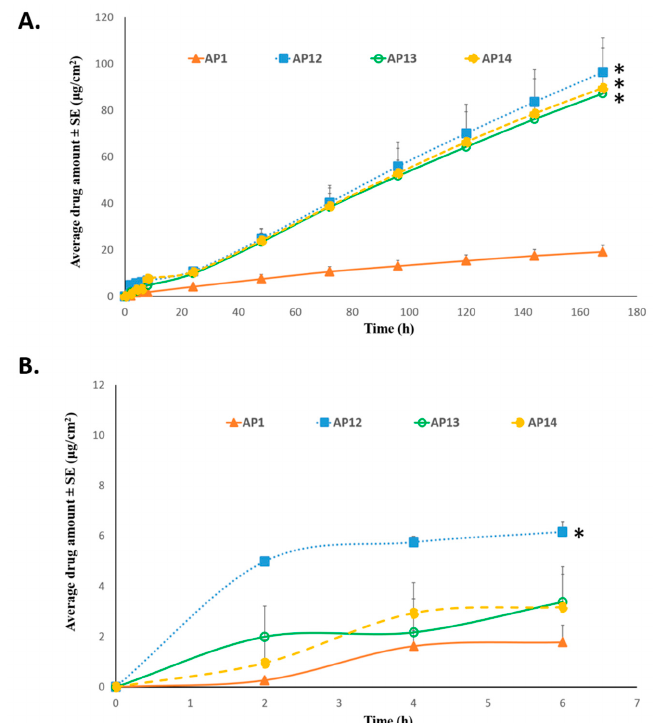
Figure 5. Effect of combination of enhancers and higher patch coat weight on permeation of TAF across human epidermis from acrylate patches: ( A ) Seven day permeation profile ( B ) Six hours permeation profile. * Represents statistically significant difference, ANOVA one way test ( p < 0.05). AP1: Acrylate based patch containing 2% TAF and 5% oleic acid. AP12: Acrylate based patch containing 2% TAF, 5% oleic acid, 5% PG, and 5% oleyl alcohol. AP13: Acrylate based patch containing 2% TAF, 5% oleic acid, 5% PG, and 5% triacetin. AP14: Acrylate based patch containing 2% TAF, 5% oleic acid, 5% PG, and 8.5% octisalate.